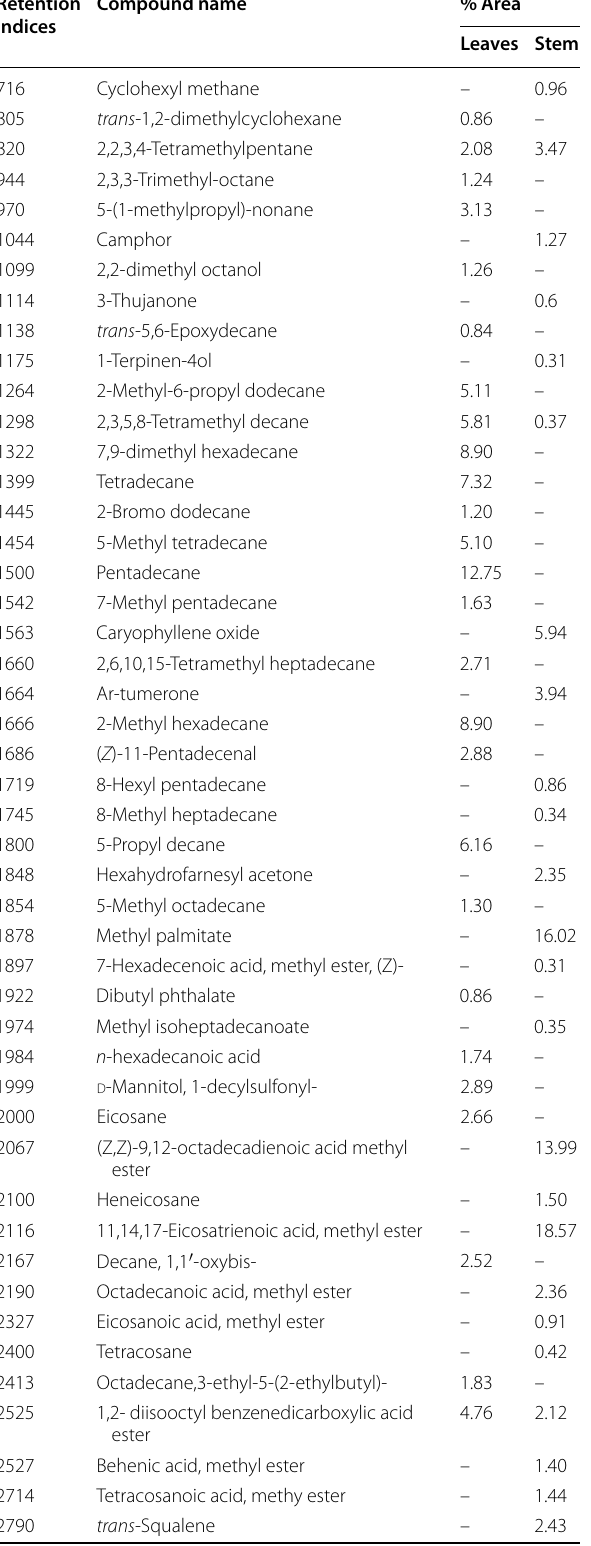
Table 1 GC/MS analysis of D. mucronata essential